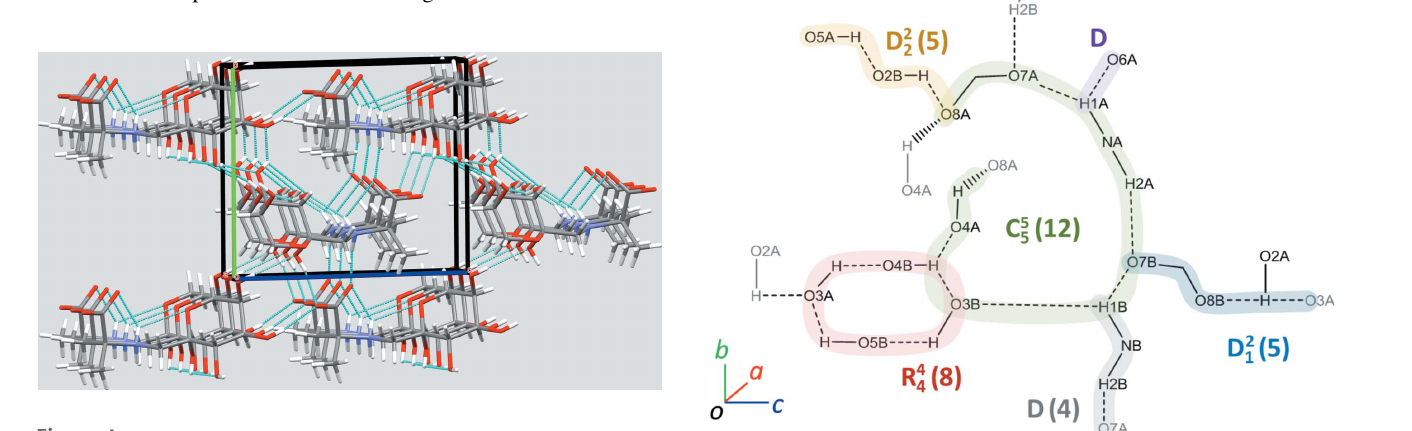
Figure 4 The molecular packing in (I). Color code for crystallographic axes: red (cid:2) a , green (cid:2) b , blue (cid:2) c . Hydrogen bonds are shown as cyan dotted lines.